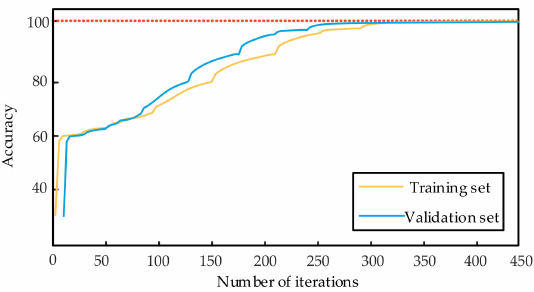
Figure 11. The accuracy change curve during the training of the location model.